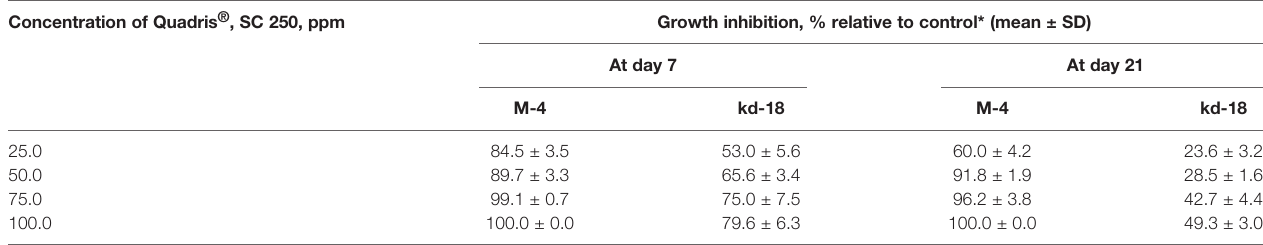
TABLE 2 | Sensitivity of the most resistant P. nodorum mutant strain (kd-18) to azoxystrobin-based Quadris ® SC 250 compared to the parental strain (M-4). Concentration of Quadris ® , SC 250, ppm Growth inhibition, % relative to control* (mean ± SD)